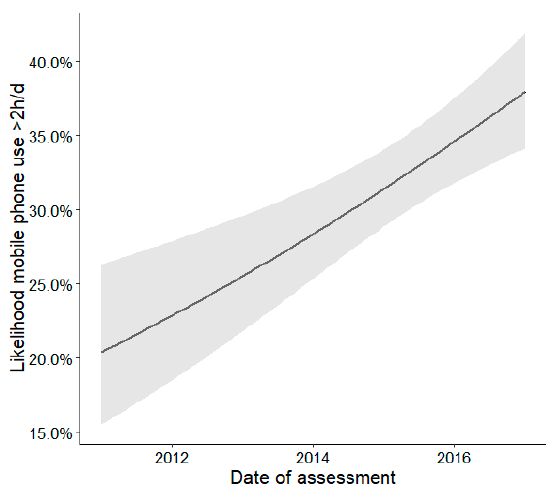
Figure 1. Effects plot illustrating the estimated changes over time (2011–2017) described as association between mobile phone use and date of assessment. The shaded area indicates the 95% confidence intervals of the estimated effect.